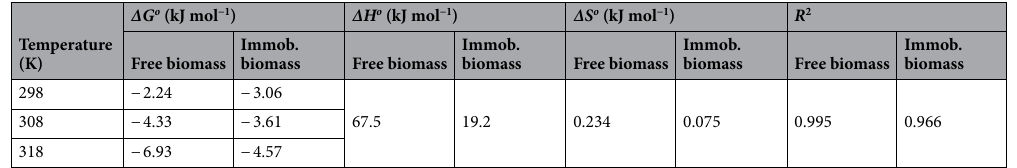
Table 4. Thermodynamic parameters for Cd 2+ biosorption with the free and immobilized T. ornata biomasses.